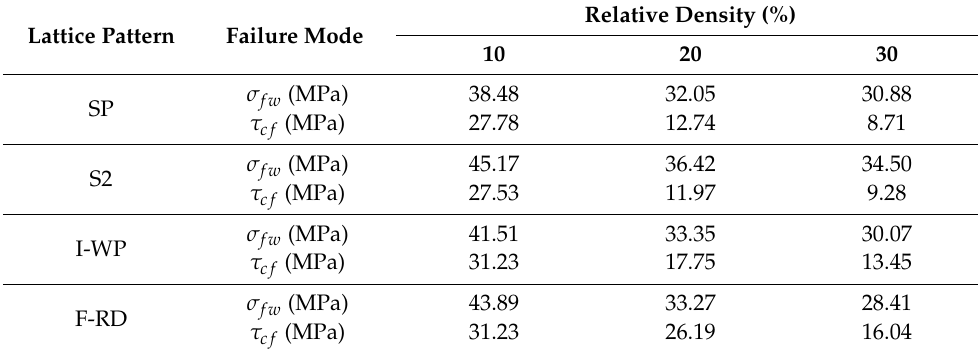
Table 11. Values of face normal stress under different relative densities.